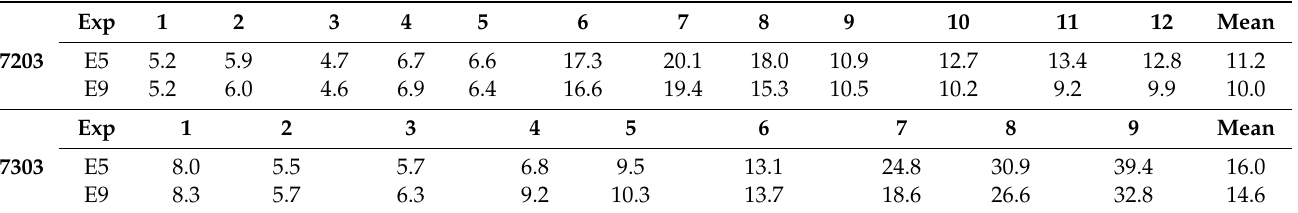
Table 9. Root–mean–square errors between simulated and observed storm surge levels in each 6-hour period during Typhoons 7203 and 7303 (unit: cm).